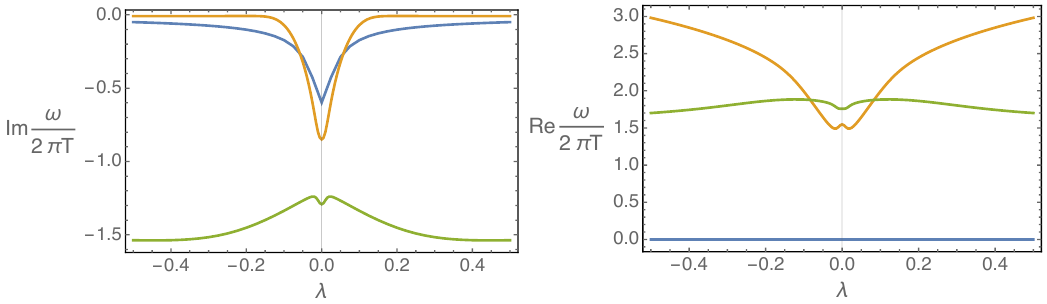
Figure 8 . The imaginary and real parts of quasinormal frequency as a function of (cid:21) at (cid:12)xed k = 4 (cid:25)T . The blue line is for the Di(cid:11)usion pole, the orange line is for the (cid:12)rst QNMs and the green line is the second